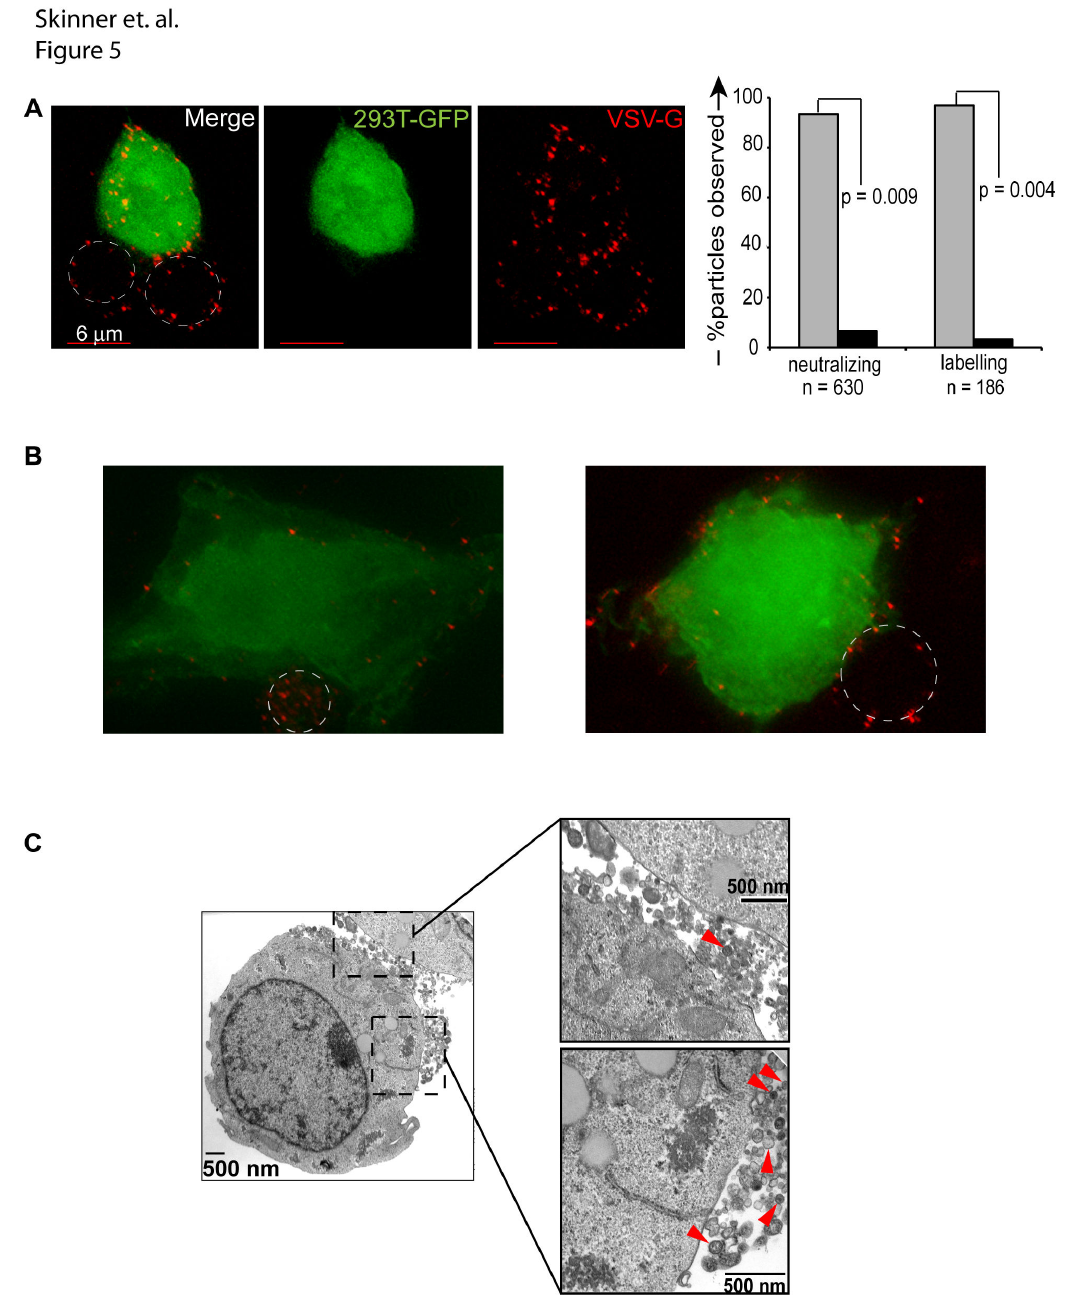
Figure 5. Vector particles do not consistently polarize to areas of cell-cell contact. ( A ) Jurkat cells were exposed to mCherry vpr vector (red) for 1 hour at 4°C, cells were washed and placed in co-culture with GFP-expressing 293T cells (green) that were pre-plated on glass cover slips. Cells were washed with PBS, stained with anti-VSV-G antibody (shown) or neutralizing anti- VSV-G antibody (not shown), fixed with 4% paraformaldehyde, and then stained with Alexa Fluor 647 anti-rabbit secondary antibody (magenta). The percentage of single or aggregated particles was enumerated in cells treated with neutralizing versus labeling VSV- G antibody. Statistical significance was determined via a 2-tailed Students t test assuming unequal variance. ( B ) A representative image was acquired as described in (A) and used to generate a projection image of 13 z -stacks in softWoRx Explorer. ( C ) 1x10 6 Jurkat cells were transduced overnight at 37°C (MOI 25). Cells were washed twice in the morning, pelleted, fixed for 1 hour in Karnovsky’s fixative, and prepared for electron microscopy. Panel on left is magnified 14,000x; the right top panel is magnified 36,000x. Red arrowheads highlight vector particles. doi: 10.1371/journal.pone.0074925.g005 PLOS ONE |